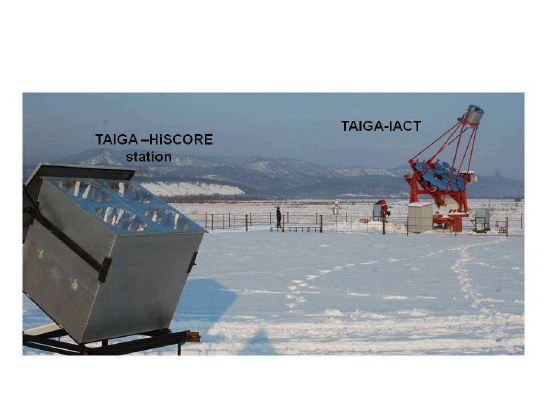
Figure 2. TAIGA-HiSCORE station and TAIGA-IACT